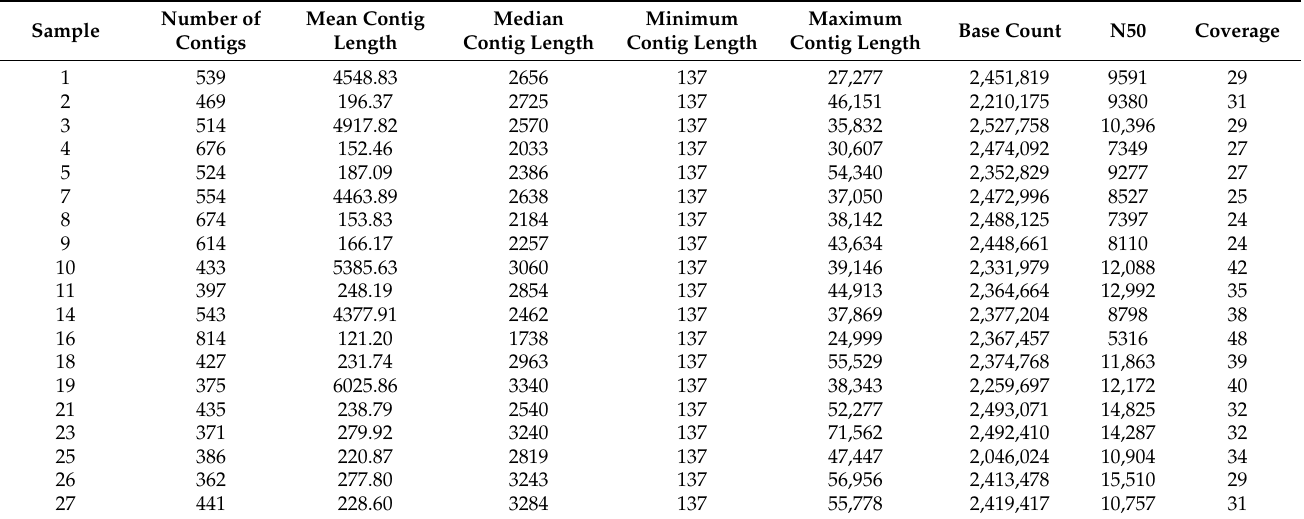
Table 2. Quality parameters of the sequenced